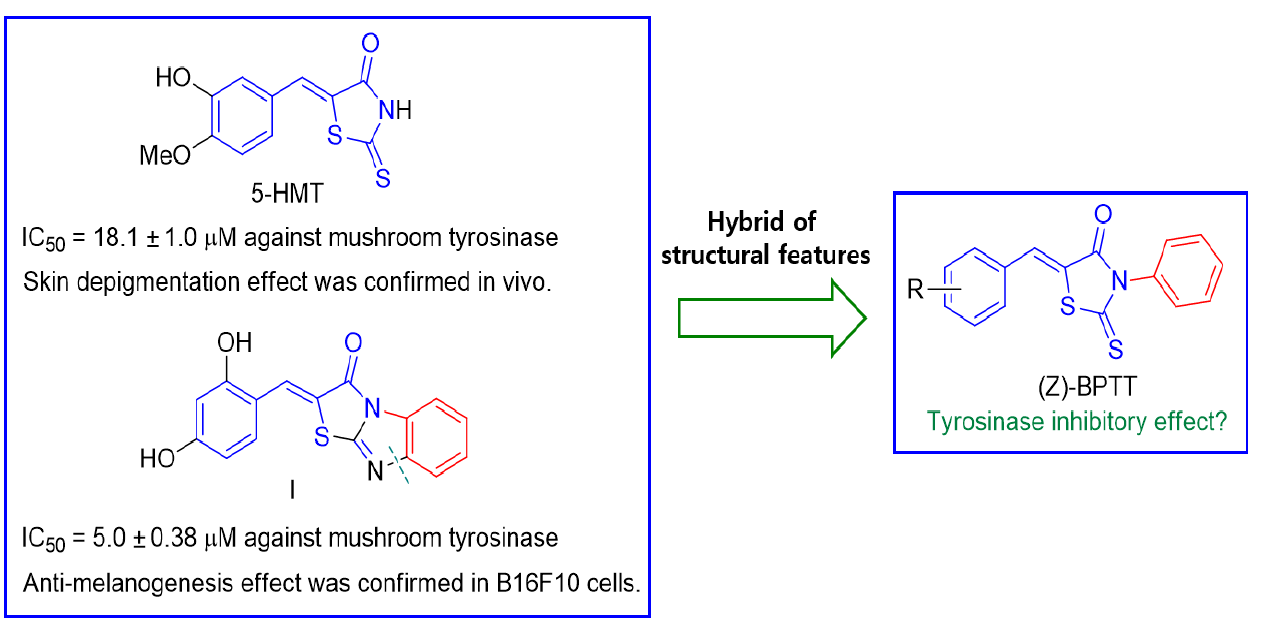
Figure 1. Schematic of the design of target compounds based on the structural characteristics of 5-HMT and compound I .